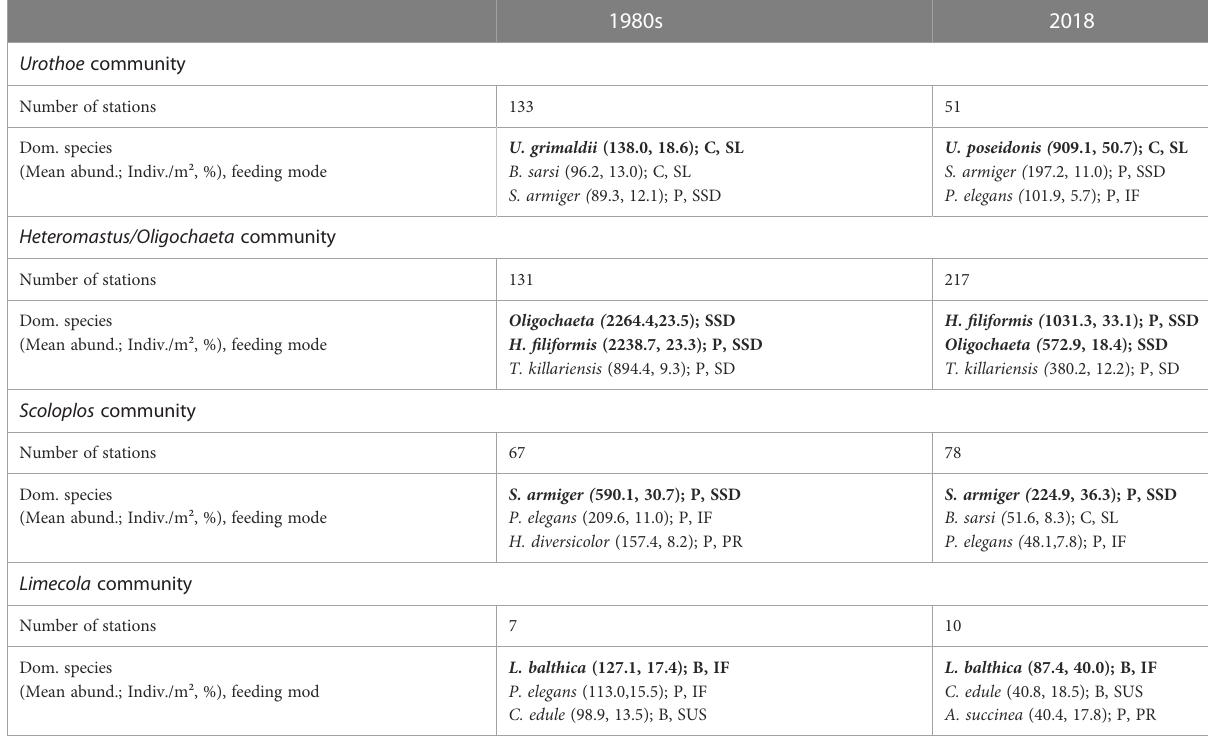
TABLE 4 Characteristic species of the four communities, separated equally for the 1980s and 2080 (results from SIMPROF and cluster analysis, R package “ clustsig ” , version